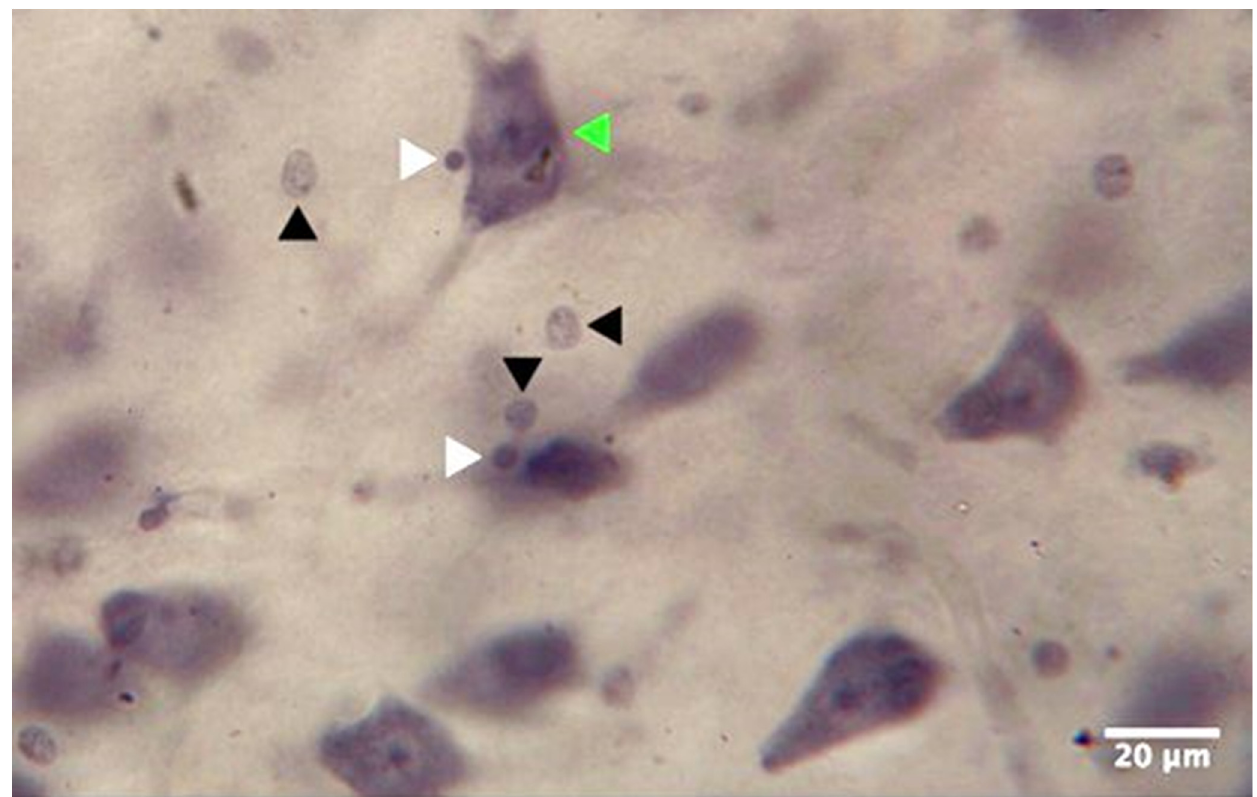
Figure 2. Photomicrograph from cornu ammonis 4 at 40× magnification showing neurons (green arrowhead), astrocytes (black arrowheads), and oligodendrocytes (white arrowheads).